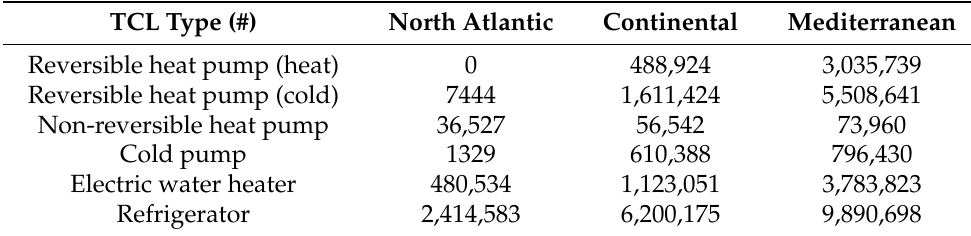
Table 2. Number (#) of TCLs per climate area in 2019.